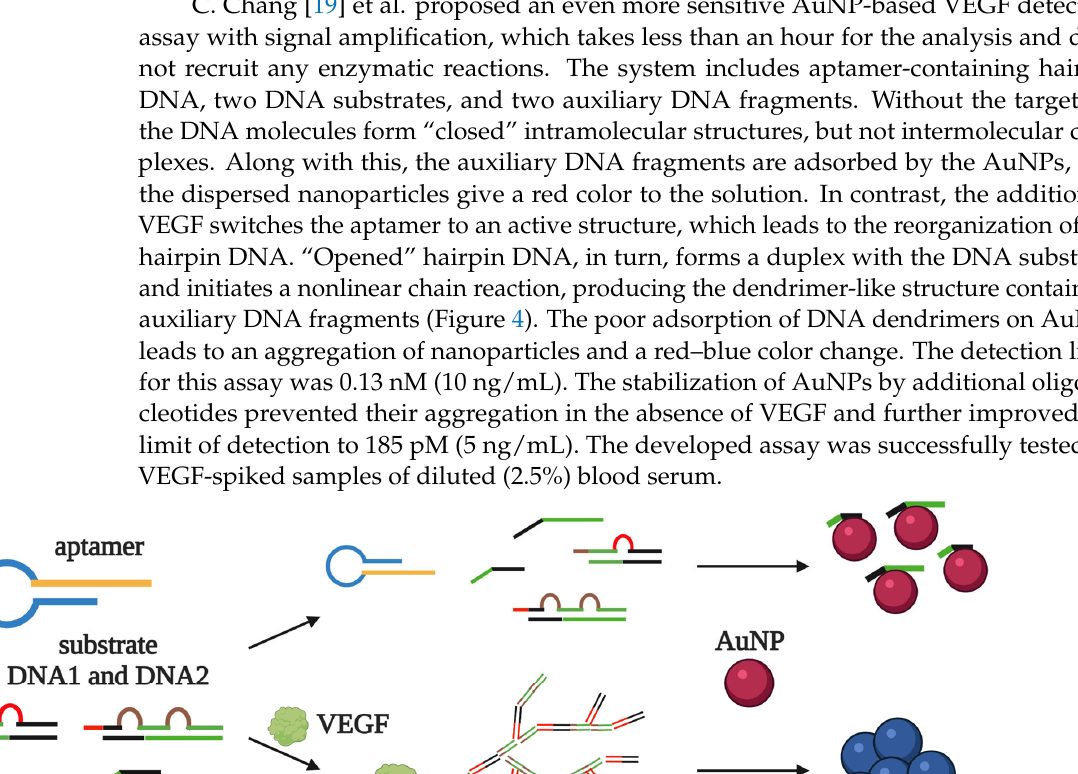
a nonlinear chain reaction involving the auxiliary DNA fragments. The resulting dendrimer-like structure is poorly adsorbed on the AuNPs, and their aggregation causes a red to blue color